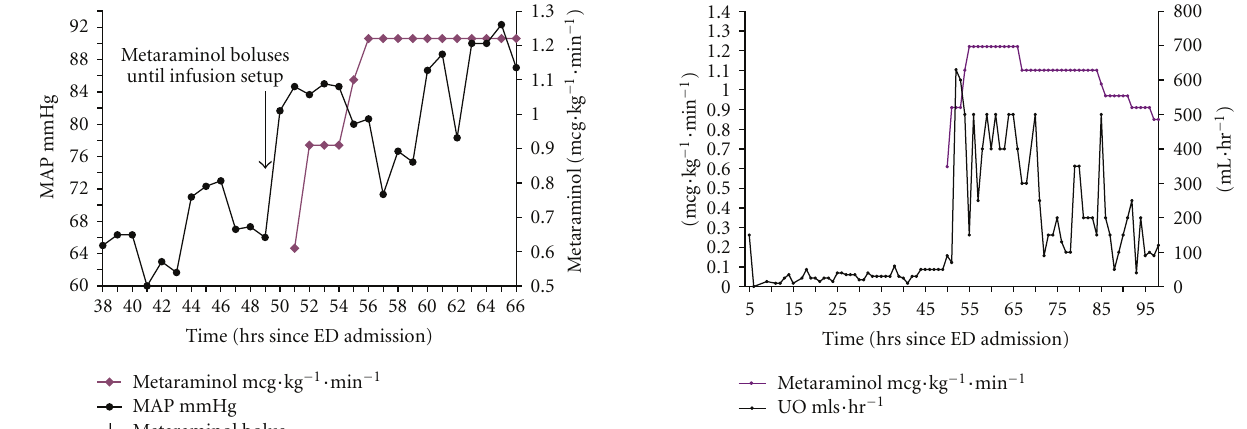
The patient was started on a metaraminol infusion 46-